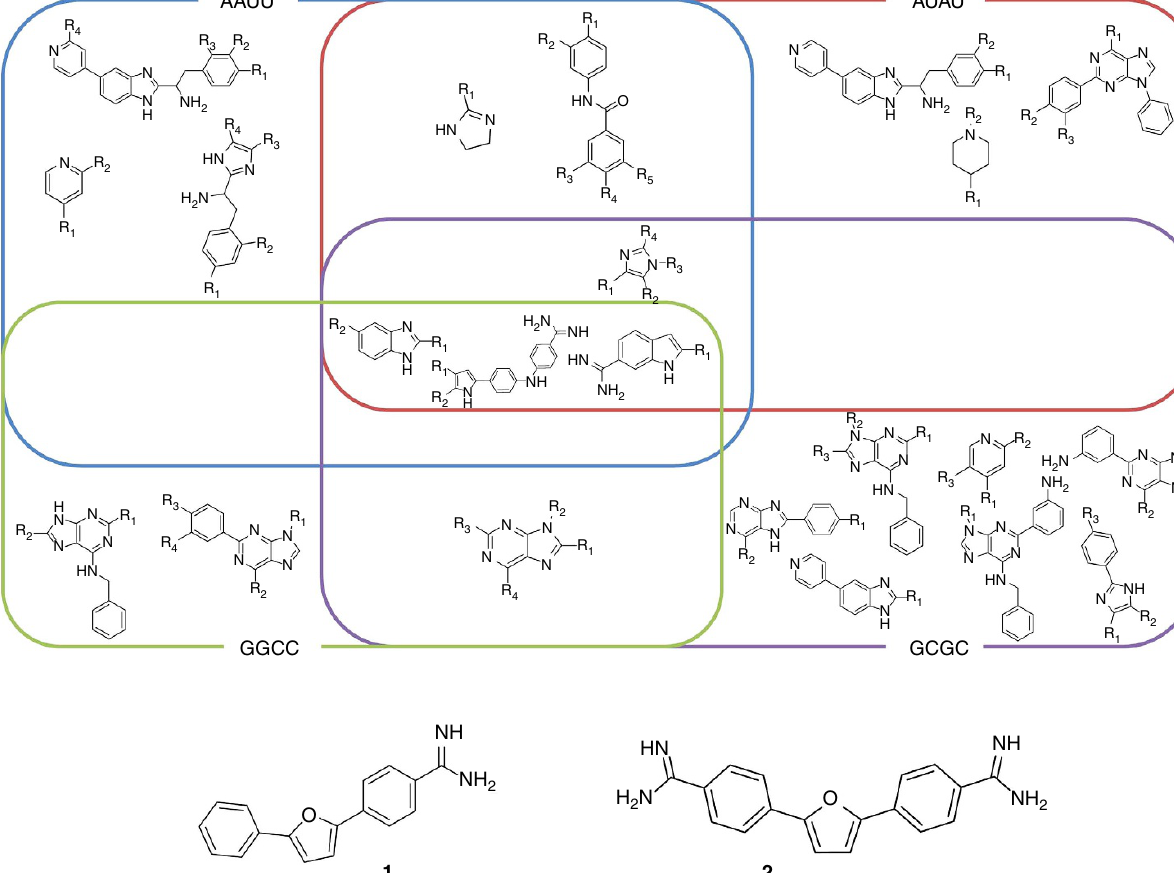
Figure 2 | Analysis of compounds identified to bind RNA base pairs. Top, Venn diagram of substructures in compounds that were found to bind to RNA from the fluorescence screening assay showed in Fig. 1c. Data were compiled by using compounds that had a P value of o 0.001 for binding to the RNA hairpins. Bottom, structures of compounds 1 and 2 that were the most avid for binding to AUAU and AAUU RNA